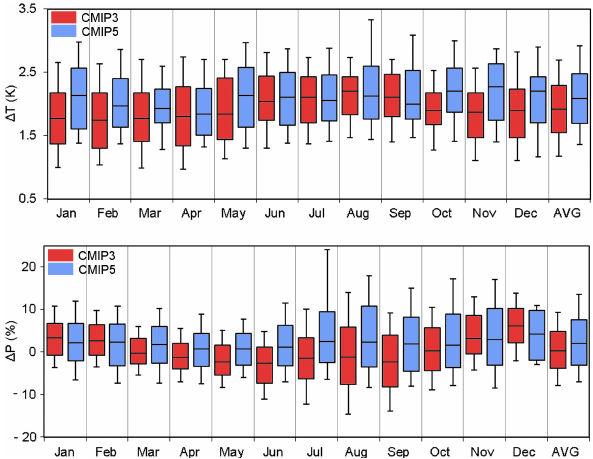
Fig. 10. Box-whisker plots for projected changed per month in 1 temperature (upper panel) and precipitation (lower panel) for the Figure 10. Box-whisker plots for projected changes per month in temperature (upper panel) 2 CMIP3 ensemble (red) and CMIP5 ensemble (blue). The definition and precipitation (lower panel) for the CMIP3 ensemble (red) and CMIP5 ensemble (blue). 3 of the boxplots is as in Fig. The definition of the boxplots is as in Figure 9. 4